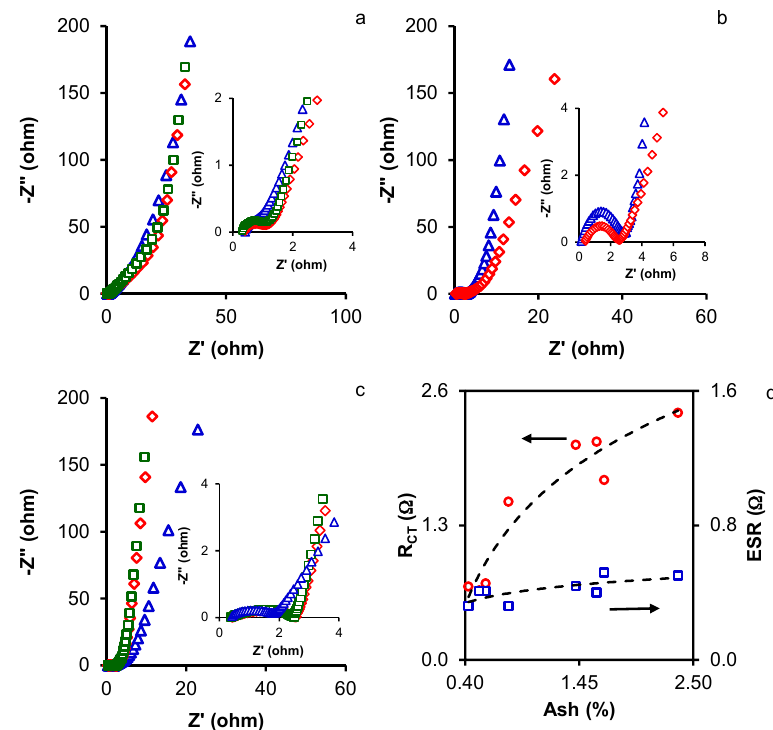
Figure 3. Nyquist plots of samples ( a ) MA1 ( △ ), MA2 ( ◇ ), and MA3 ( □ ); ( b ) CMA2 ( △ ), and CMA4 ( ◇ ); and ( c ) HMA100-2 ( △ ), HMA150-2 ( ◇ ), and HMA200-2 ( □ ). ( d ) The relationship between ESR ( □ ) and R CT ( ○ ) with the ash content of the activated carbons.